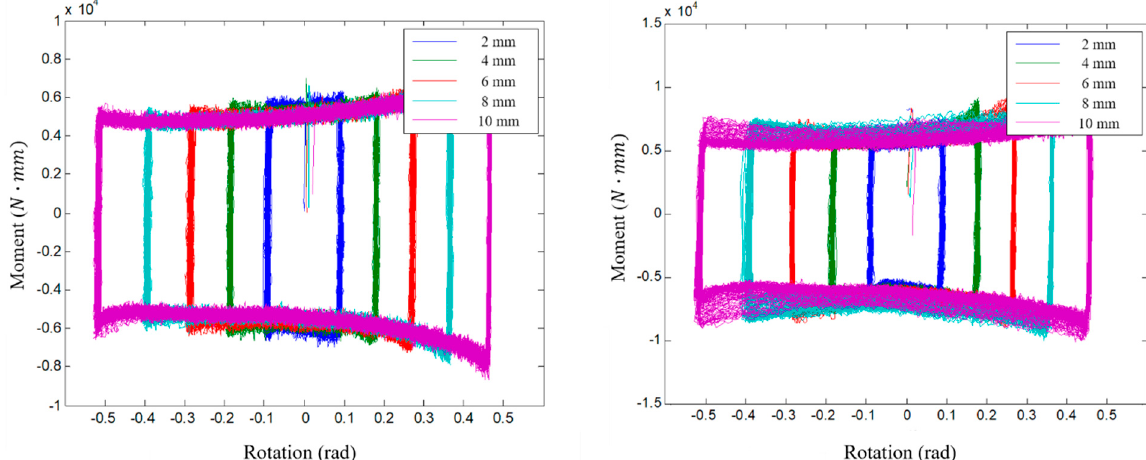
Figure 21. Displacement dependence test results by frequency. ( a ) 0.5 Hz; ( b ) 2 Hz.